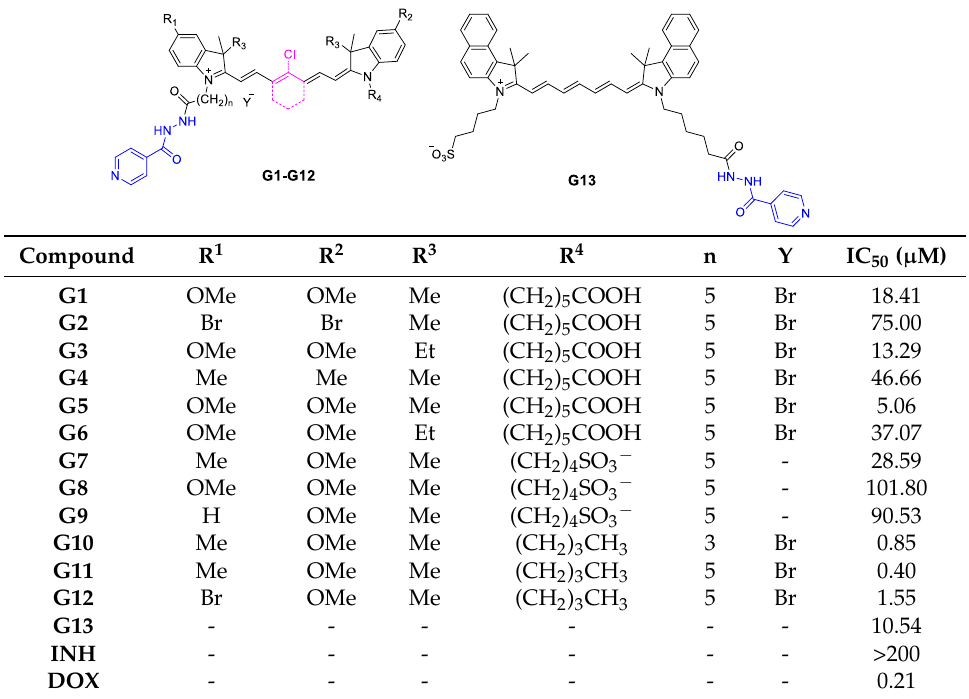
Table 1. Anti-proliferative activities of compounds against PC-3 cells (IC 50 , μM). DOX: doxorubicin.